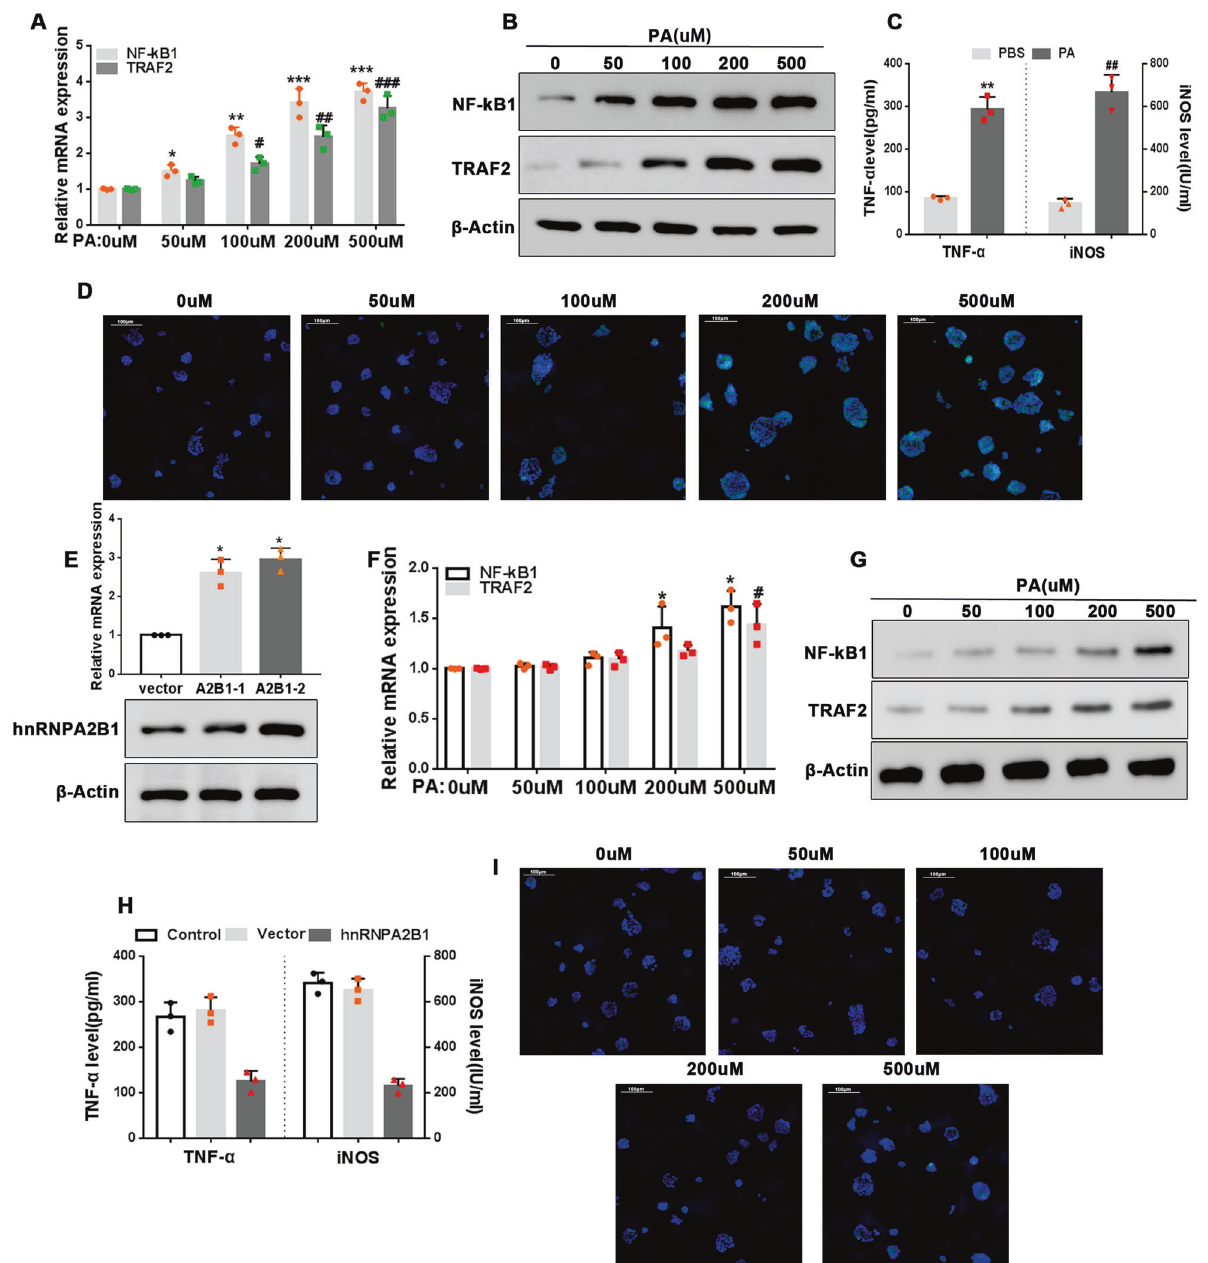
Fig. 4 hnRNPA2B1 overexpression inhibits NF- κ B activation by PA. A , B , D AR42J cells were treated with PA at the indicated concentrations for 12 h. A Relative mRNA expression levels of NF- κ B1 and TRAF2 were assessed by qRT-PCR. B NF- κ B1 and TRAF2 protein expression levels were examined by western blot analysis. D Representative immuno fl uorescence images showing staining for the NF- κ B subunit P65. Green, P65; blue, DAPI, scale bar = 100 μ m. n = 3; *, # P < 0.05, ** , ## P < 0.01, *** , ### P < 0.001 vs. 0 μ M PA. C AR42J cells were treated with 500 μ M PA for 12 h. TNF- α levels and intracellular iNOS concentrations were measured by ELISA. n = 3; * P < 0.05, ## P < 0.01 vs. PBS. E AR42J cells were transfected with the pcDNA3.1-hnRNPA2B1 plasmid or empty vector. hnRNPA2B1 mRNA and protein levels were assessed by qRT-PCR and western blot analyses, respectively. n = 3, * P < 0.05 vs. vector. F , G , I AR42J cells transfected with the pcDNA3.1-hnRNPA2B1 plasmid were treated with PA at the indicated concentrations for 12 h. F Relative mRNA expression levels of NF- κ B1 and TRAF2 were determined by qRT- PCR. G NF- κ B1 and TRAF2 protein levels were examined by western blot analysis. I Representative immuno fl uorescence images showing staining for P65. Green, P65; blue, DAPI, scale bar = 100 μ m. n = 3; * , # P < 0.05, ** P < 0.01 vs. 0 μ M PA. H AR42J cells transfected with